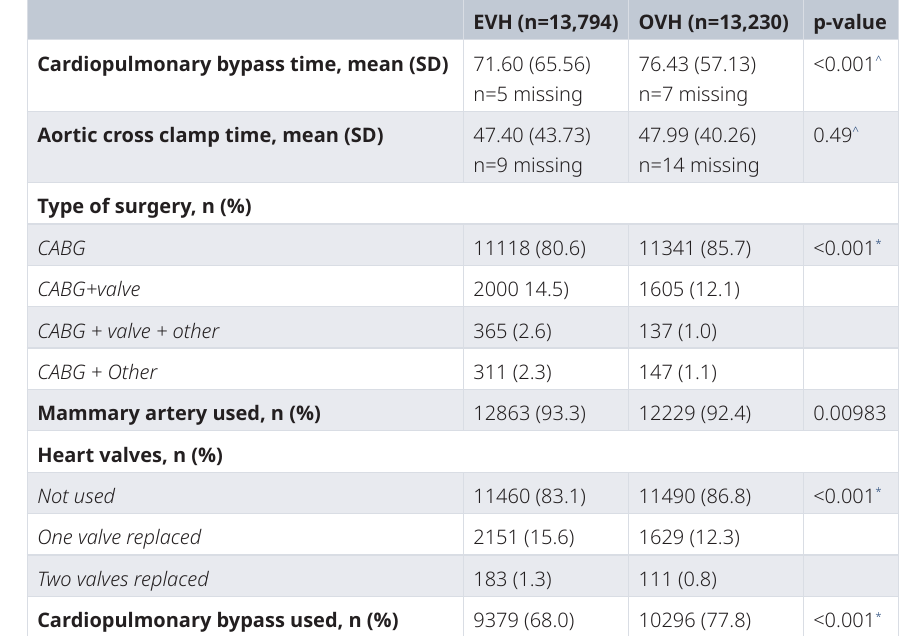
Mortality The primary outcome measure for the study was post- operative mortality. Across the follow-up period of the study (median 1656 days for EVH and 2191 days for OVH), deaths from any cause occurred for 13.8% of EVH patients and 20.8% of OVH patients. In-hospital death occurred at similar rates